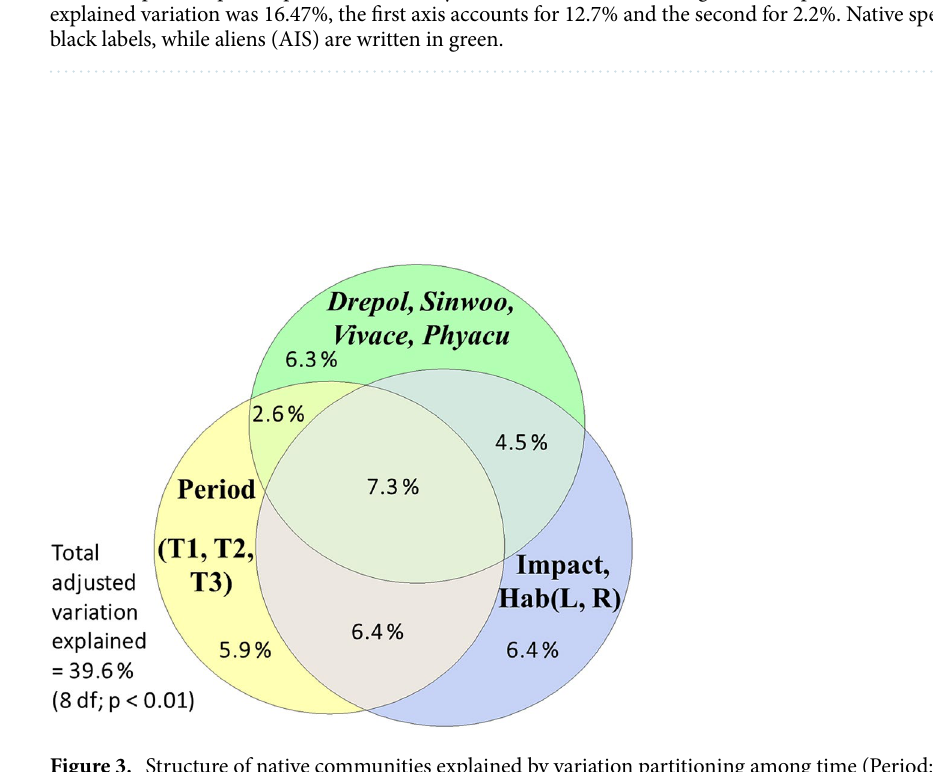
Figure 3. Structure of native communities explained by variation partitioning among time (Period: with levels T1—XIXth century, T2—1995–2000, T3—2020), environmental features (human impact—Impact, and habitat—Hab: R—river, lotic sector; L—lake, a lentic sector in reservoirs) and the selected alien invasive species—AIS (Drepol— Dreissena polymorpha , Sinwoo— Sinanodonta woodiana , Vivace— Viviparus acerosus , Phyacu— Physa acuta ). RDA with hierarchical permutation scheme was used, interactive forward selection of predictors; both simple and conditional effects are significant ( p <